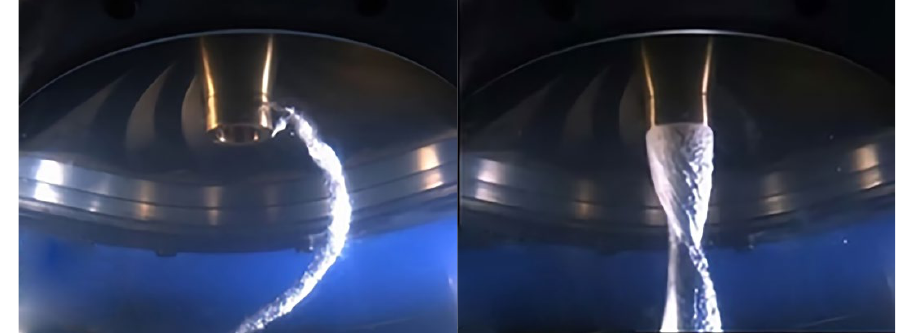
Figure 5. Vortex rope structure [20].